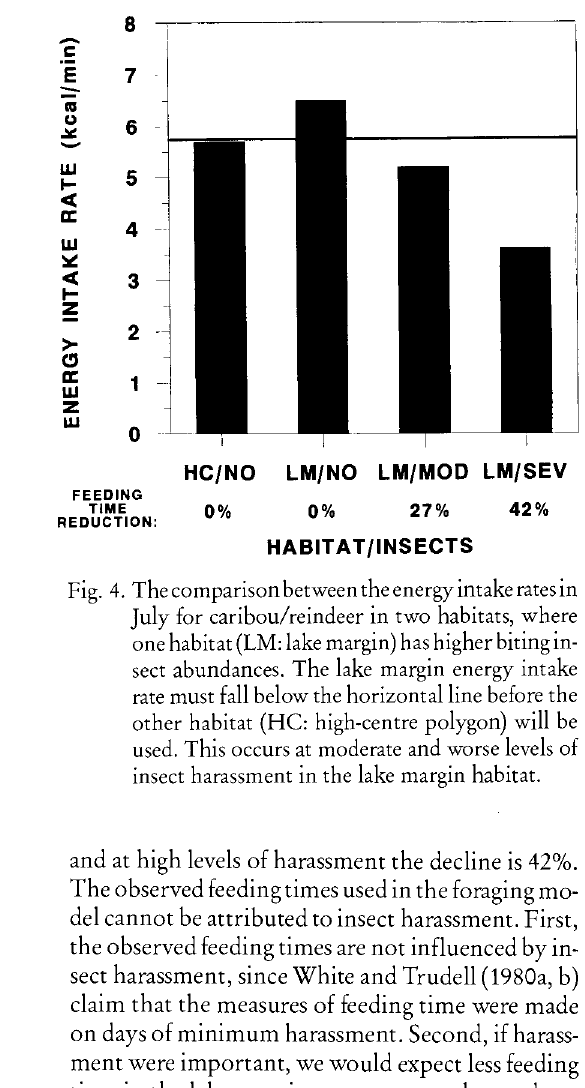
and at high levels of harassment the decline is 42%. The observed feeding times used in the foraging mo del cannot be attributed to insect harassment. First, the observed feeding times are not influenced by in sect harassment, since White and Trudell (1980a, b) claim that the measures of feeding time were made on days of minimum harassment. Second, if harass ment were important, we would expect less feeding time in the lake margin, not more as observed.